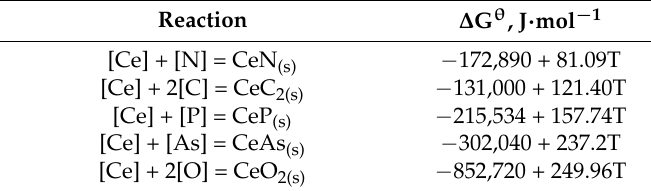
Table 4. Thermodynamic data of some deoxidization reactions at 1873 K